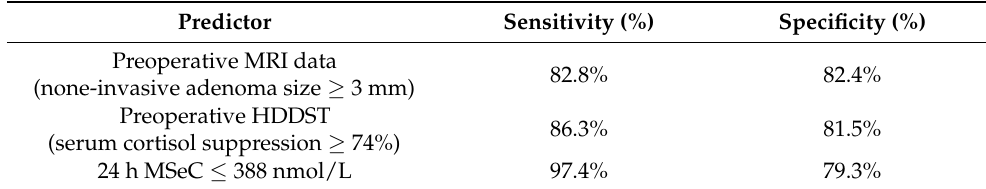
Table 4. Sensitivity and specificity of defined CD remission predictors.